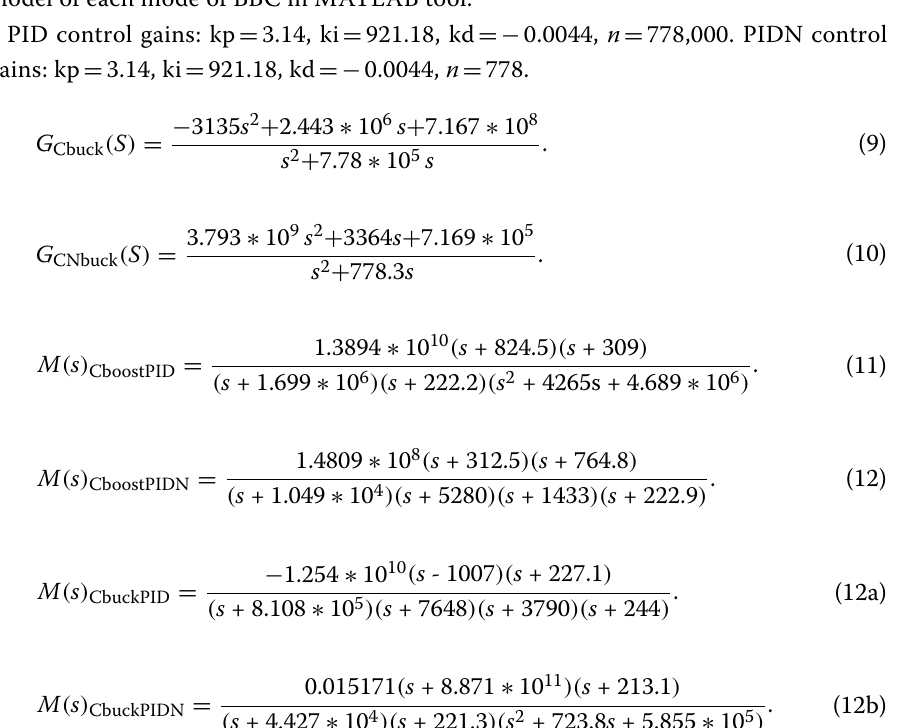
4.63, ki 1039.4, kd 0.0048, n = = = 1039.4, kd 0.0048, n 17,031. = = =